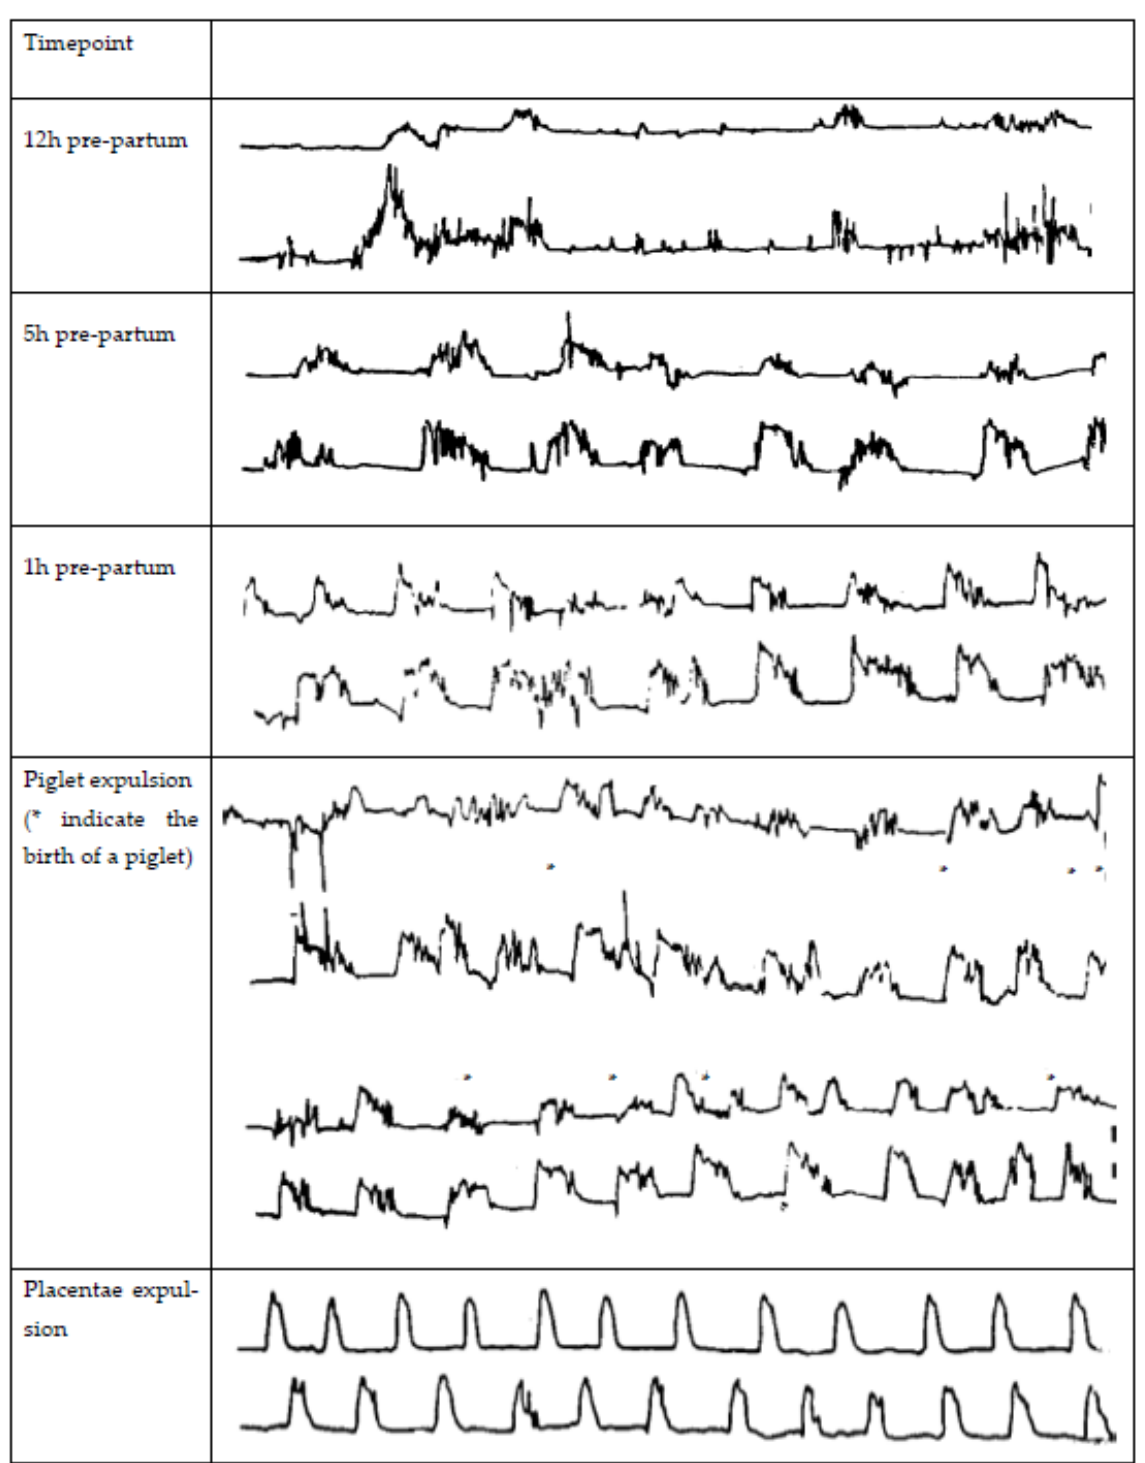
Figure 1. Myometrial contractions in the sow 12, 5, and 1 h pre-partum during spontaneous partu- rition (* indicate the birth of a piglet) and during the placentae expulsion, measured by two stain gauges implanted in each uterine horn as adapted from Maffeo et al. [15].